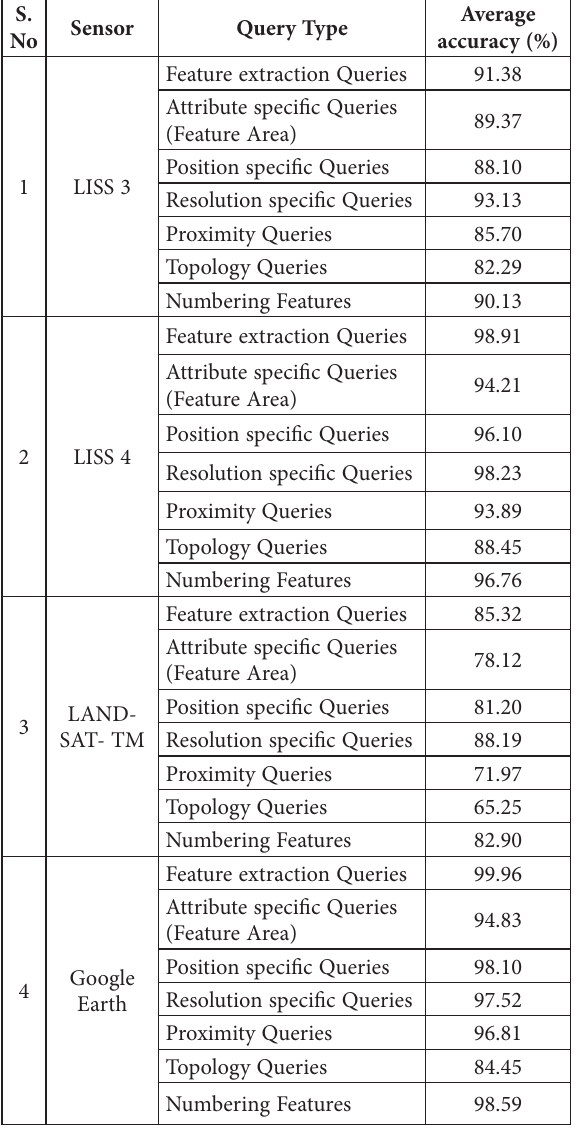
Table 1. Performance summary for advanced queries